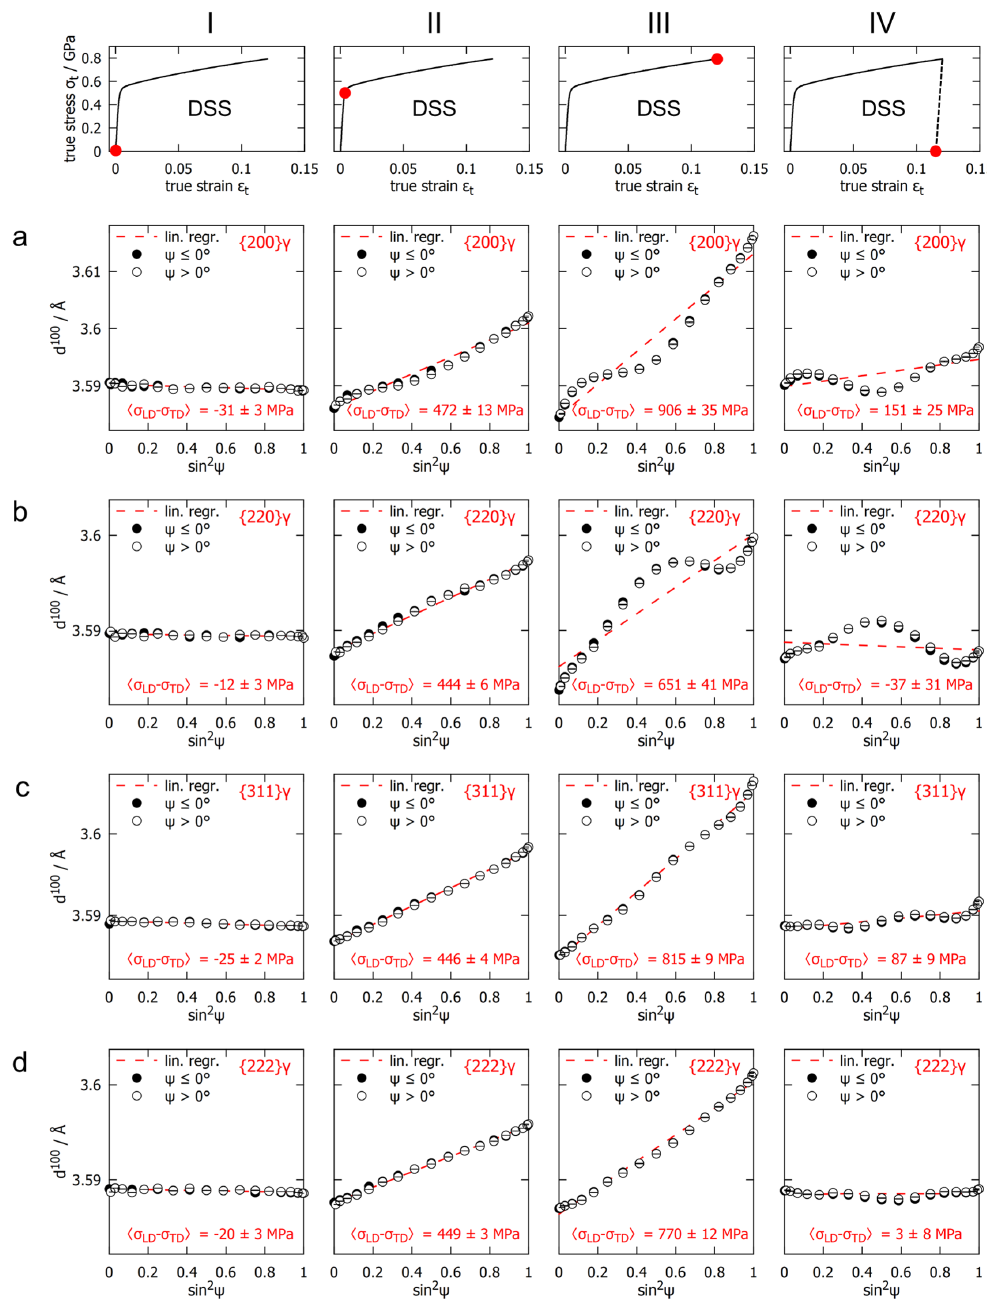
Figure 8. d 100 − sin 2 ψ distributions of austenite lattice planes { 200 } γ ( a ), { 220 } γ ( b ), { 311 } γ ( c ) and { 222 } γ ( d ) for selected load states during tensile deformation of the DSS: initial state ( I ), macroscopic yield strength ( II ), plastically deformed ( III ) and unloaded after deformation ( IV ); stress differences (cid:104) σ − σ (cid:105) γ determined by linear regression (red dotted line) according to the sin 2 ψ LD TD